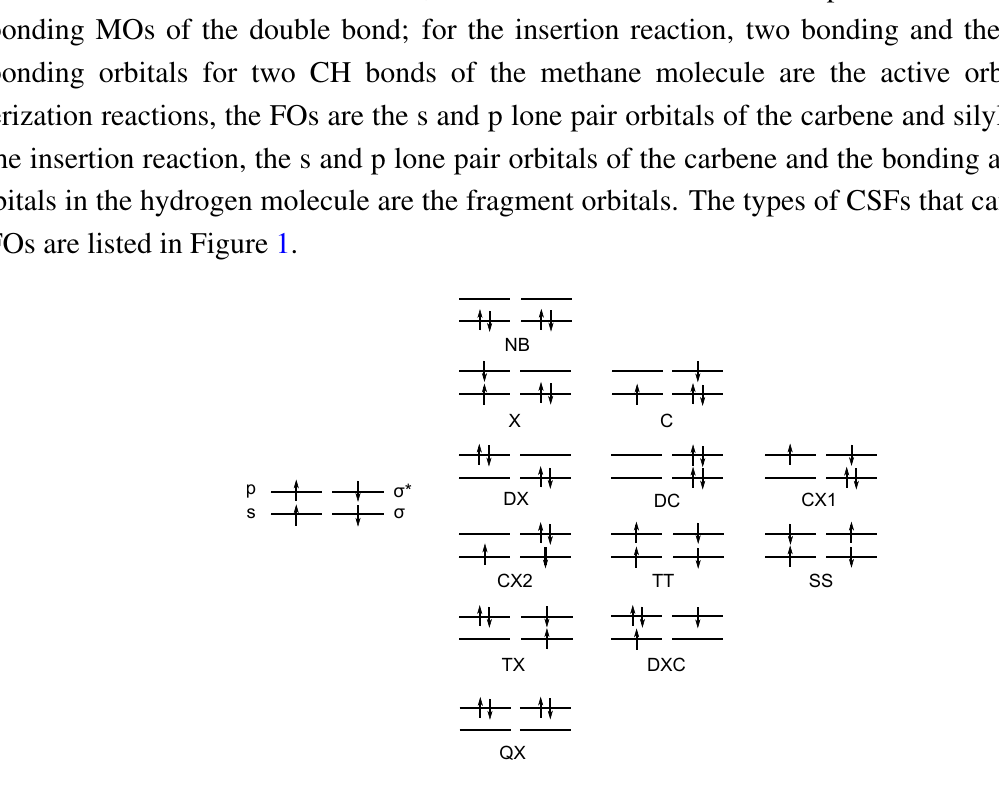
Figure 1. The types of fragment orbital (FO)-configuration state functions (CSFs) used for the insertion reaction. NB, the no-bond configuration, in which the lowest FO of each fragment is doubly occupied; X, a single excitation in one fragment; C, single-charge transfer; DX, double excitations in one fragment; DC, double-charge transfer; CX, single-charge transfer and single excitation; TT, singlet coupling of two local triplets; SS, singlet coupling of two local singlets; TX, double excitation in one fragment and a single excitation in the other; DXC, double excitation and a charge transfer; QX, quadruple excitation; σ and σ ∗ are the bonding and antibonding H 2 MOs,